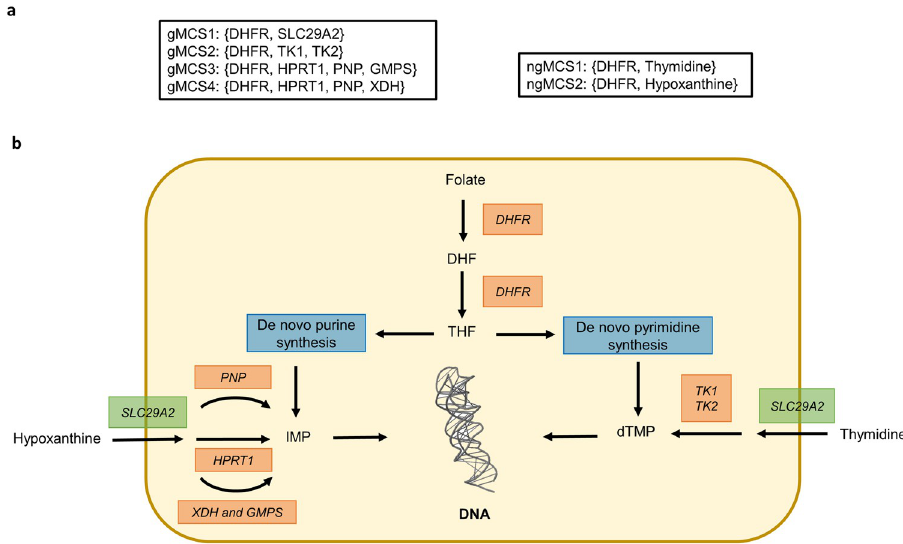
Fig 2. Predicted synthetic lethals involving DHFR with thymidine and hypoxanthine in the growth medium. (a) 4 genetic Minimal Cut Sets (gMCSs) and 2 nutrient-genetic Minimal Cut Sets (ngMCSs) involving DHFR. They were derived from Recon3D under the RPMI1640 growth medium plus thymidine and hypoxanthine; ( b) Simplified network of metabolites and enzymes implied in the synthesis of purines and pyrimidines, emphasizing the role of DHFR, Thymidine and Hypoxanthine. Abbreviations: DHF: dihydrofolate; THF: tetrahydrofolate; IMP: inosinic acid; dTMP: 5-Thymidylic acid; DHFR: dihydrofolate reductase; PNP: purine nucleoside phosphorylase; HPRT1: hypoxanthine phosphoribosyltransferase 1; XDH: xanthine dehydrogenase; GMPS: Guanine Monophosphate Synthase; TK1: thymidine kinase 1; TK2: thymidine kinase 2; SLC29A2: solute carrier family 29 member